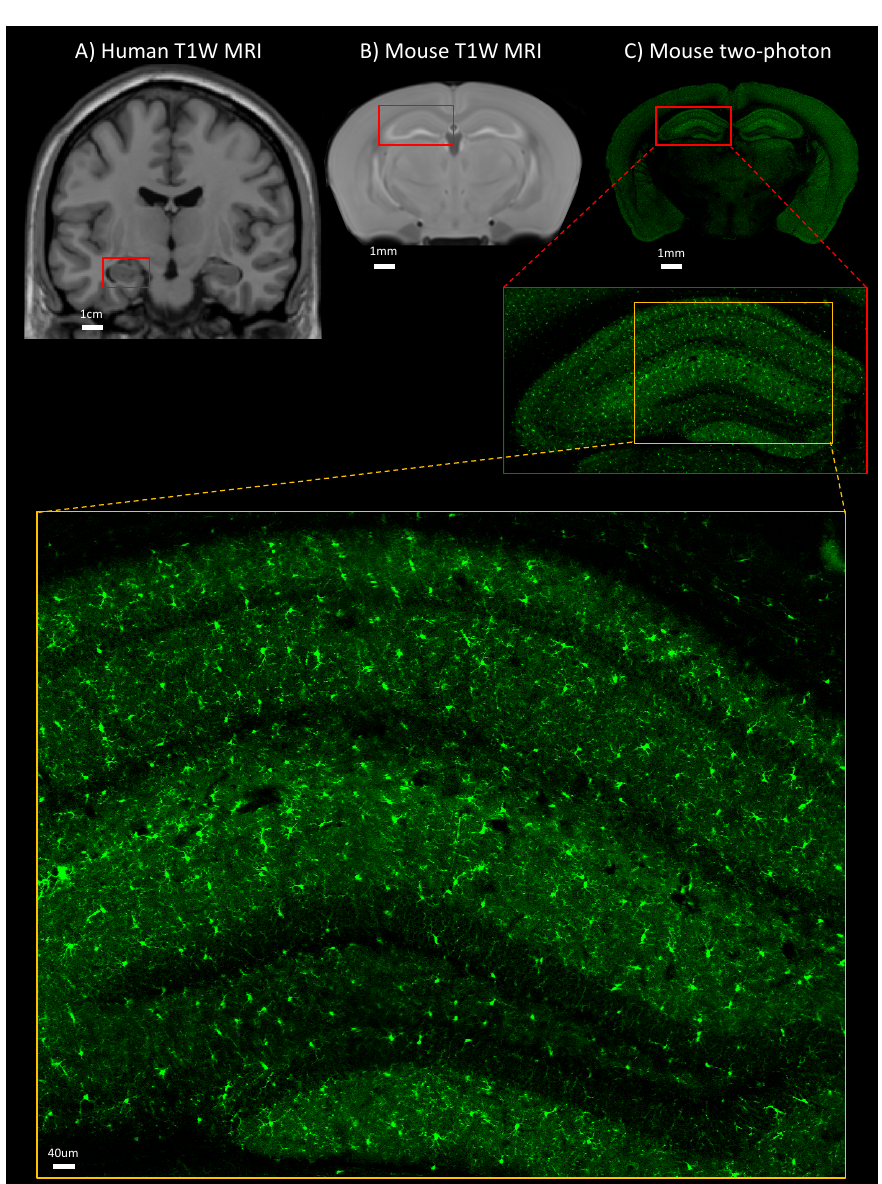
Figure 1. Coronal sections of the brain: ( A ) T1W MR image in humans, ( B ) T1W MRI in mice, and ( C ) two-photon microscopy in microglia-reporter mouse labeled with GFP. Red and yellow rectangles indicate the hippocampus and its subsections. T1W: T1-weighted, MRI: magnetic resonance imaging, GFP: green fluorescent protein. Unpublished data are shown.